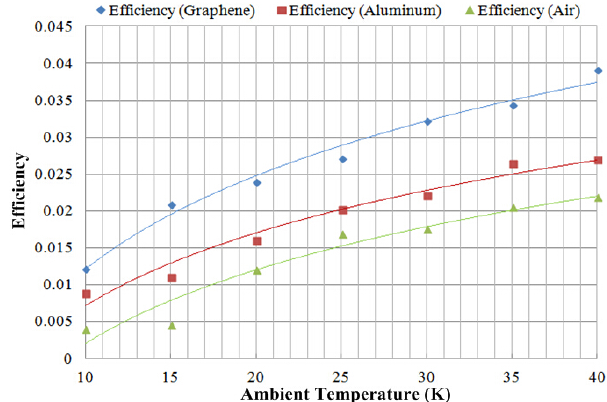
Figure 17. Conversion efficiency of TE board attached with different thermally conductive materials against temperature difference.